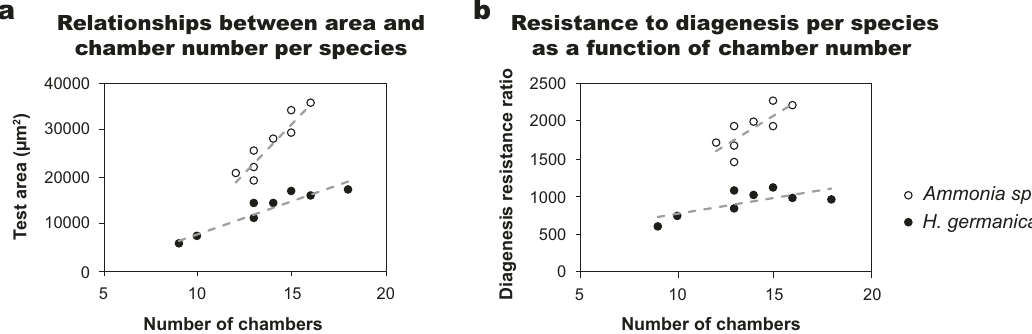
Fig. 6 Variation in diagenetic susceptibility to isotopic exchange per species and during ontogeny. Relationship between the number of chambers and foraminifera test cross-sectional area ( a ) and diagenesis resistance ratio for Ammonia sp. and H. germanica , calculated as a ratio of the foraminifera test cross-sectional area to the number of chambers ( b ). a The cross-sectional test wall area ( µ m 2 ) and the number of chambers show a good statistical correlation for both Ammonia sp. ( r 2 = 0.85) and H. germanica ( r 2 = 0.89). For the same number of chambers, Ammonia sp. test walls have larger cross- sectional areas than H. germanica tests because the walls are thicker in this species. b Plotting the diagenesis resistance ratio to the number of chambers shows that H. germanica has a lower resistance to diagenesis than Ammonia sp. and that, as foraminifera from both species grow more chambers, their diagenetic resistance ratio